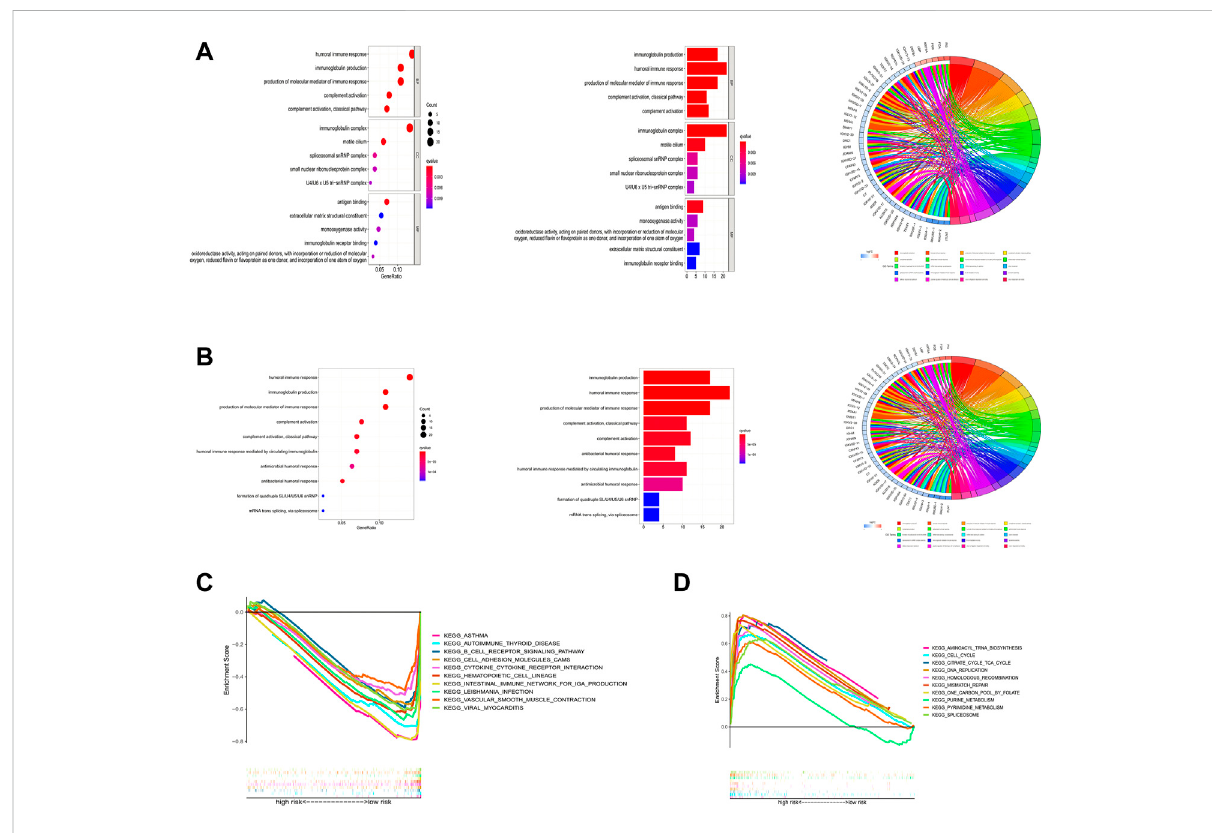
FIGURE 10 Functional enrichment analysis. (A) Result of GO enrichment. (B) Result of KEGG enrichment. (C,D) Result of